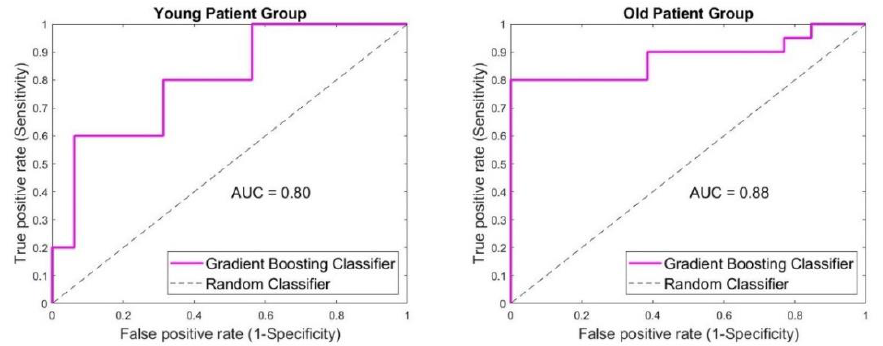
Figure 5. Density effect on SAFE classification outcome. Higher sensitivity, specificity and accuracy (91%, 100% and 93%, respectively) were achieved when non-dense breasts were involved compared to the ones acquired in dense breasts (56%, 83% and 67%, respectively).